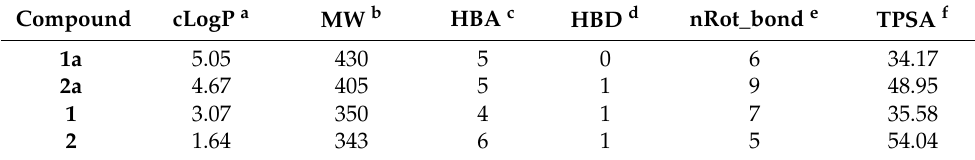
Table 1. Calculated descriptors related to the Lipinski’s rules and the Veber’s rules, referred to the 1a , 2a previously discovered mTAAR5 antagonists and to the newly screened compounds 1 and 2 . a cLogP as the logarithmic ratio of the octanol–water partitioning coefficient, b MW as the molecular weight of compounds, c HBA represents the number of H-bonding acceptor groups, d HBD represents the number of H-bonding donor groups, e nRot_bonds as number of rotable bonds, f TPSA represents the topological polar surface area. Compound cLogP a MW b HBA c